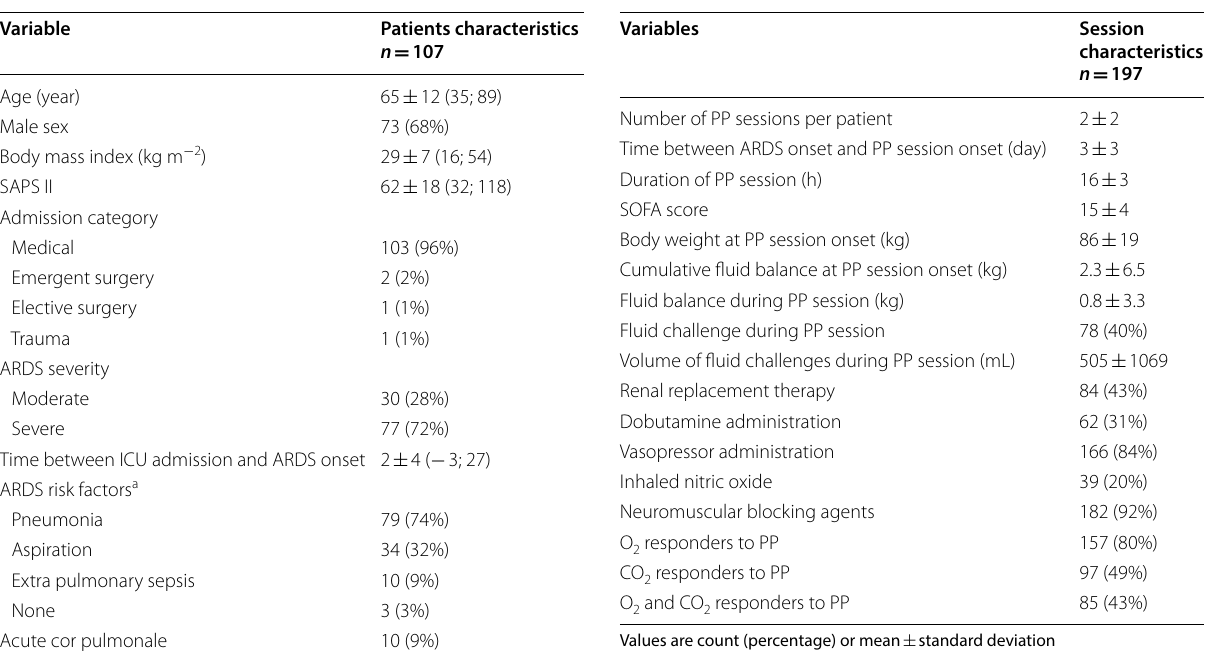
Table 1 Patients’ characteristics Table 2 Characteristics of prone positioning